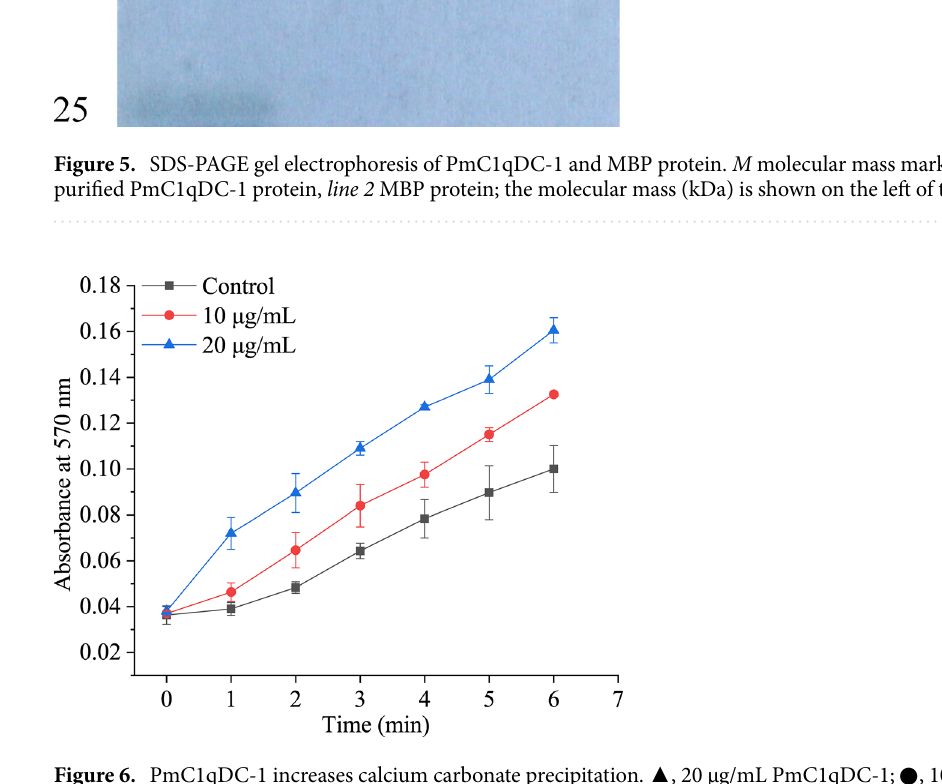
Figure 6. PmC1qDC-1 increases calcium carbonate precipitation. ▲ , 20 μg/mL